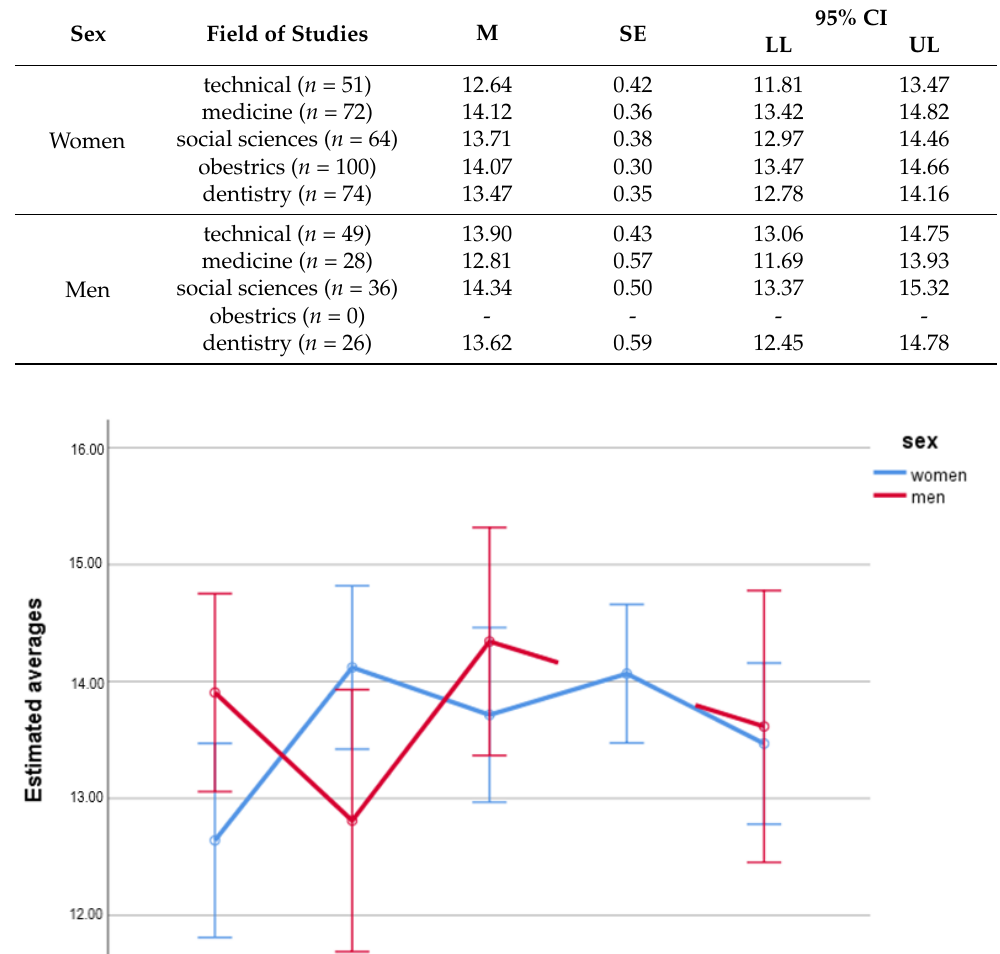
Table 4. Descriptive statistics for psychological health domain with regard to sex and field of studies.